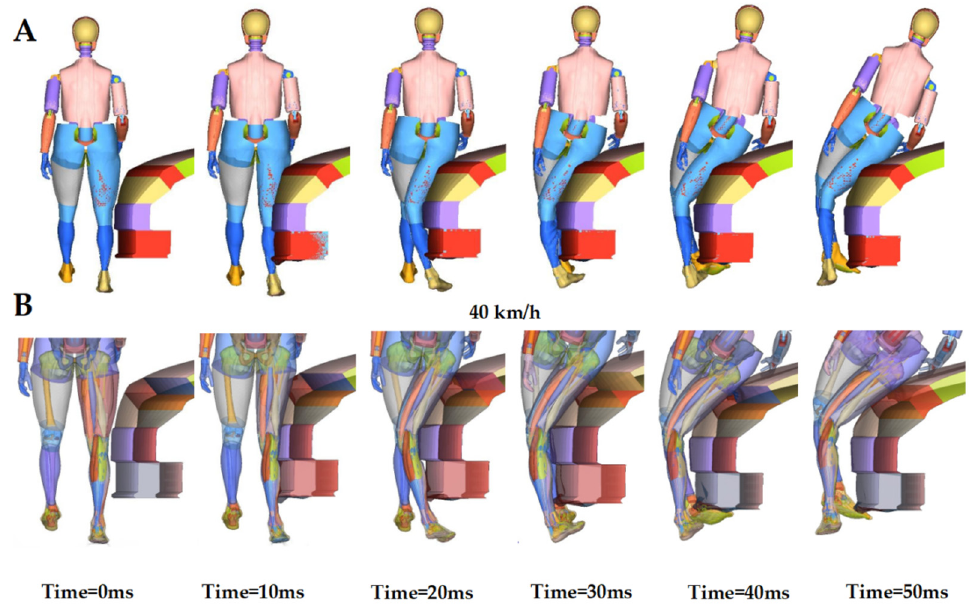
Figure 5. The collision motion process of HALL model 50ms. ( A ) Overall collision process. ( B ) HALL model transparent collision process.